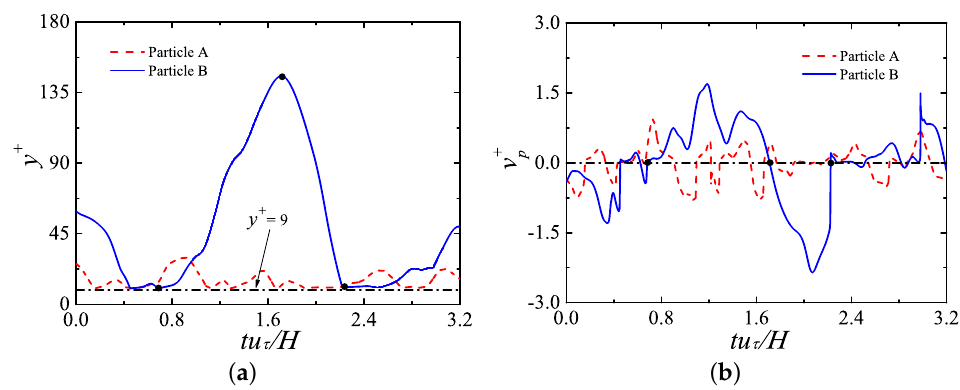
Figure 11. Time histories of two typical particle wall-normal motions extracted from case φ = 0.44%: ( a ) Center positions and ( b ) center velocities. If a particle touches the bottom wall, its normalized center position in the wall-normal direction is at y + = 9. Transport times tu τ / H = 0.7, 1.7, and 2.2 are marked with symbol “ • ”. Side view animation can be found in video S2 in the Supplemen- tary